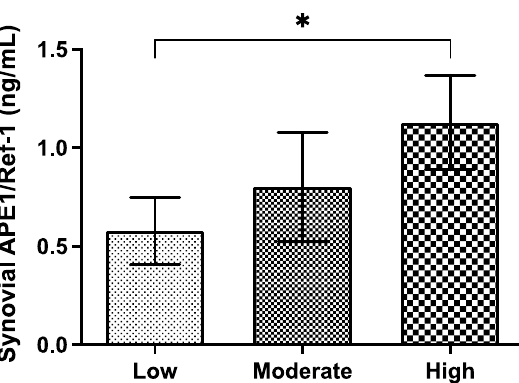
Figure 5. Synovial APE1/Ref-1 levels according to disease activity categories. The synovial APE1/Ref-1 concentrations were associated with disease activity categories. Columns represent the mean; bars represent the SD. * p < 0.05 vs. low based on one-way ANOVA analysis followed by Bonferroni’s multiple comparison test.